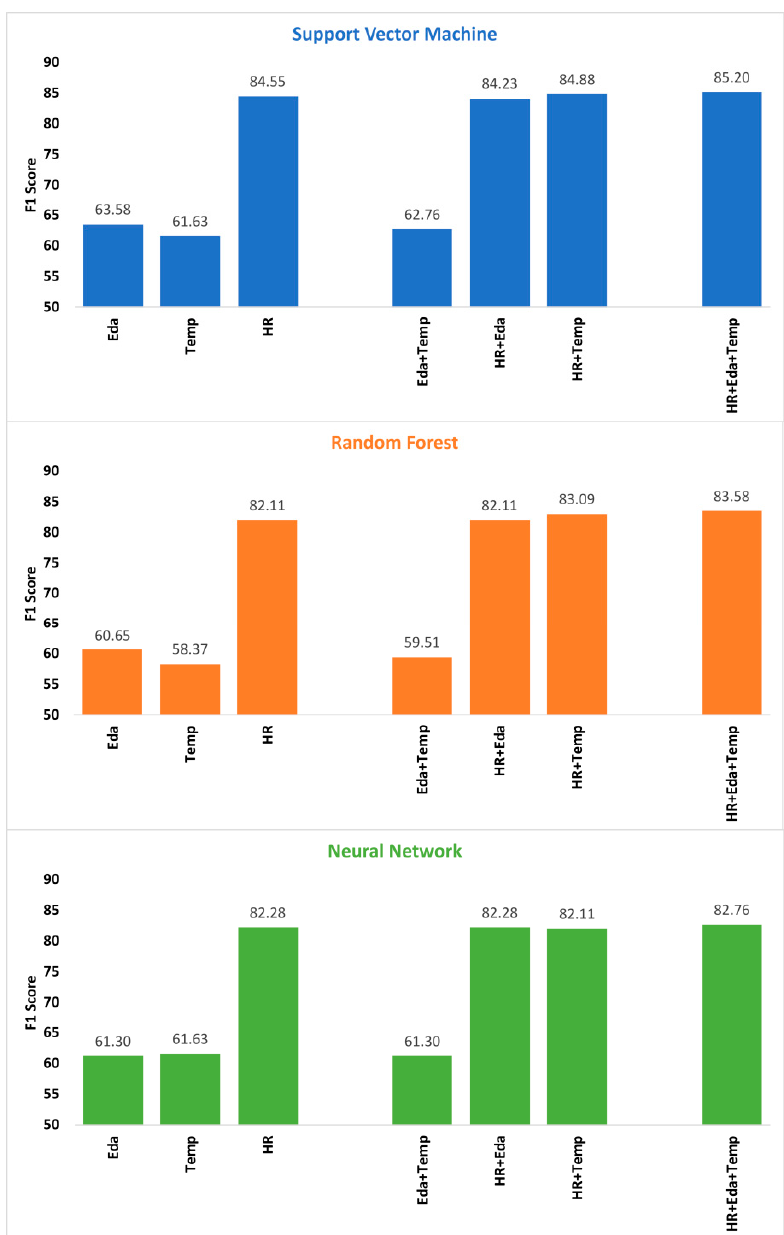
Figure 1. F1 Scores for all combinations of modalities using feature fusion; Note: results of single modalities are also given as base-lines. Abbreviations: Eda = electrodermal activity; HR = heart-rate; Temp = temperature.